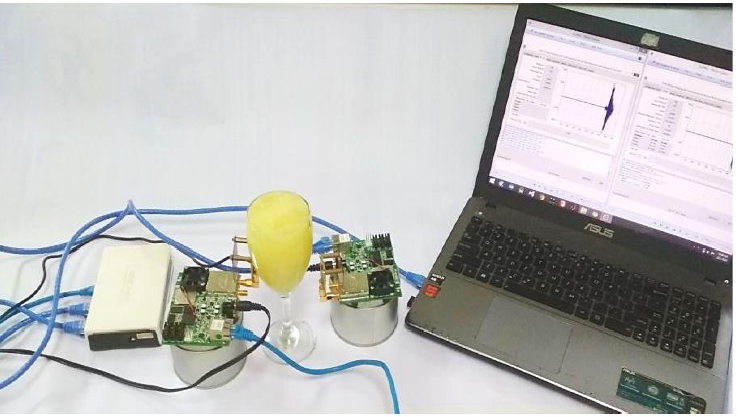
Figure 10. Radar imaging experimental